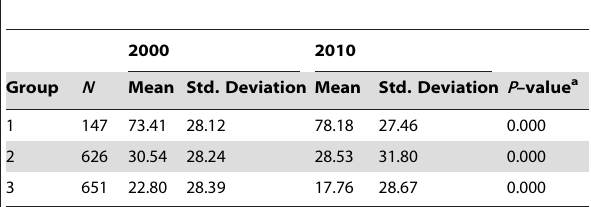
Table 2. Mean forest